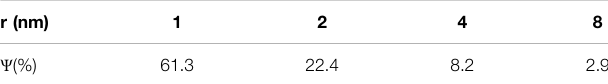
TABLE 8 | In fl uence of con fi nement effect on apparent permeability deviation.